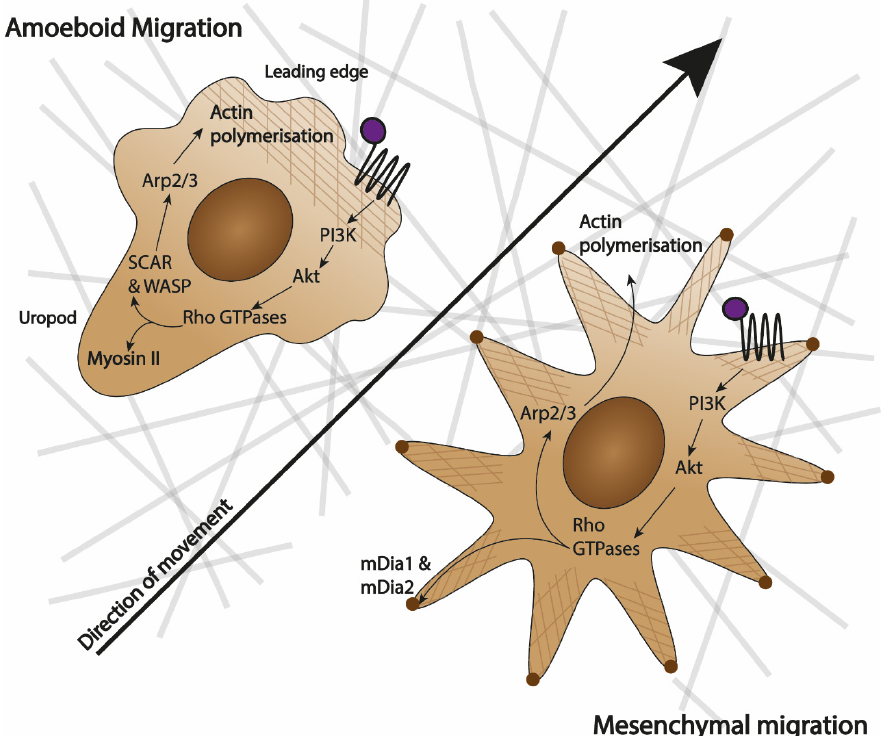
Figure 1. Similarities and differences between amoeboid and mesenchymal movement. Amoeboid migration is characterised by a ‘hand-mirror’ cell shape with a clear leading edge and a lagging uropod, whilst mesenchymal migration does not have a defined shape and is characterised by multiple lamellipodia. Amoeboid cells do not degrade extracellular matrix (ECM) that they move on (represented by the grey lines), while mesenchymal cells do. When a chemoattractant attaches to a receptor (purple dot attaching to 7 transmembrane domains), in both cases, it activates a PI3K/Akt cascade that leads to Rho GTPases. In amoeboid cells, Rho GTPases either directly activate Myosin II in the uropod or cause actin (represented by brown grid) polymerisation at the leading edge by activating SCAR and WASP proteins, and subsequently Arp2/3 [21,24]. In mesenchymal cells, Rho GTPases either activate formins mDia1 and mDia2 to create adhesion points (brown dots) to the ECM or acting via Arp2/3 cause actin polymerisation that lead to the extending of lamellipodia.[21].